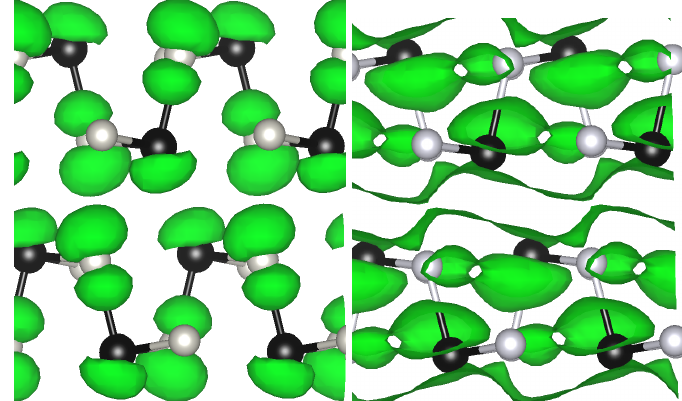
Figure 7. Plot of | ψ | 2 for Γ v ( left ) and Γ c ( right ). In green the isosurfaces at 1% of maximum value. The represented atoms are: Ge (black), S